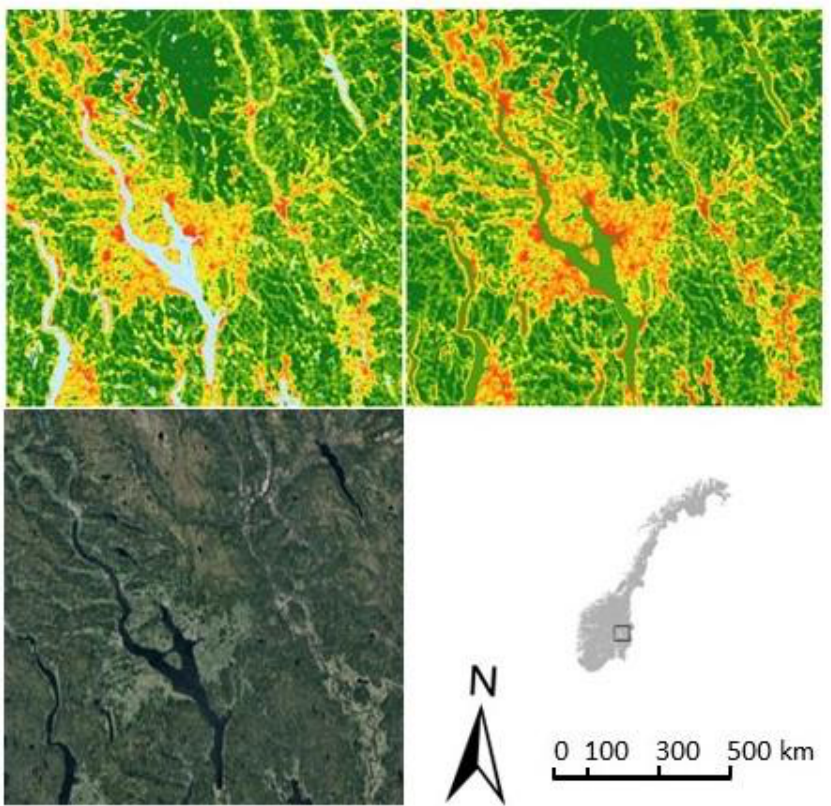
Figure 5. Maps of central SE Norway showing the LUI index in its original (left) and extended (right) version. Legend as in Figure 2. Below is satellite imagery over the area (Google